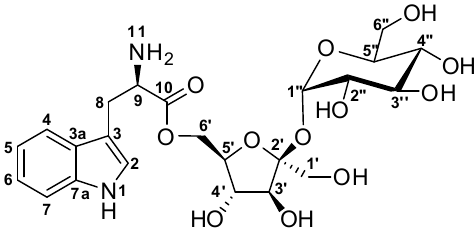
Figure 1. Structure of α- D -Glucopyranosyl-(1 → 2)-[6- O -( L -tryptophanyl)-β- D -fructofuranoside] ( 1 ).